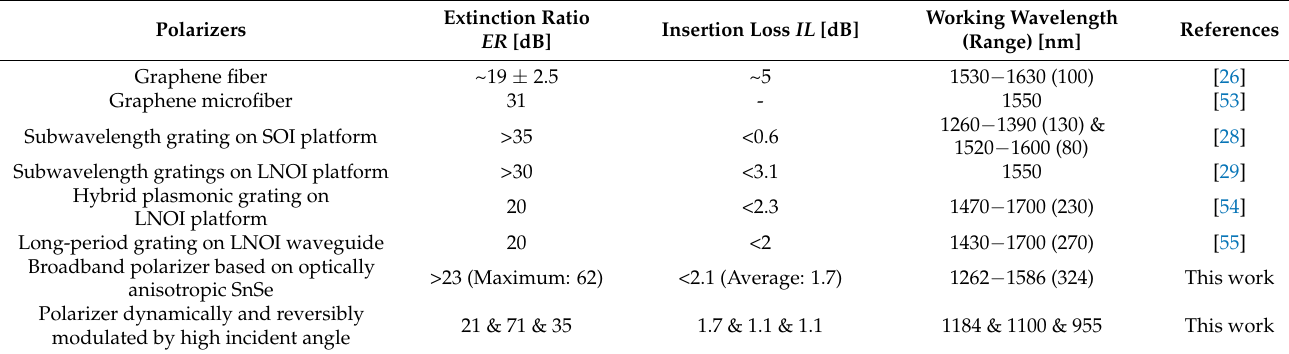
Table 1. Comparation of performances of near-infrared